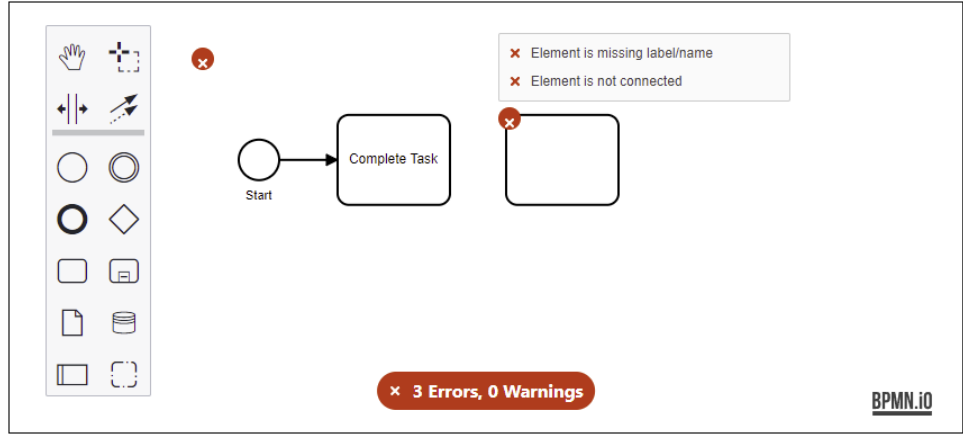
Figure 9. Bpmnlint incorporated into bpmn.js